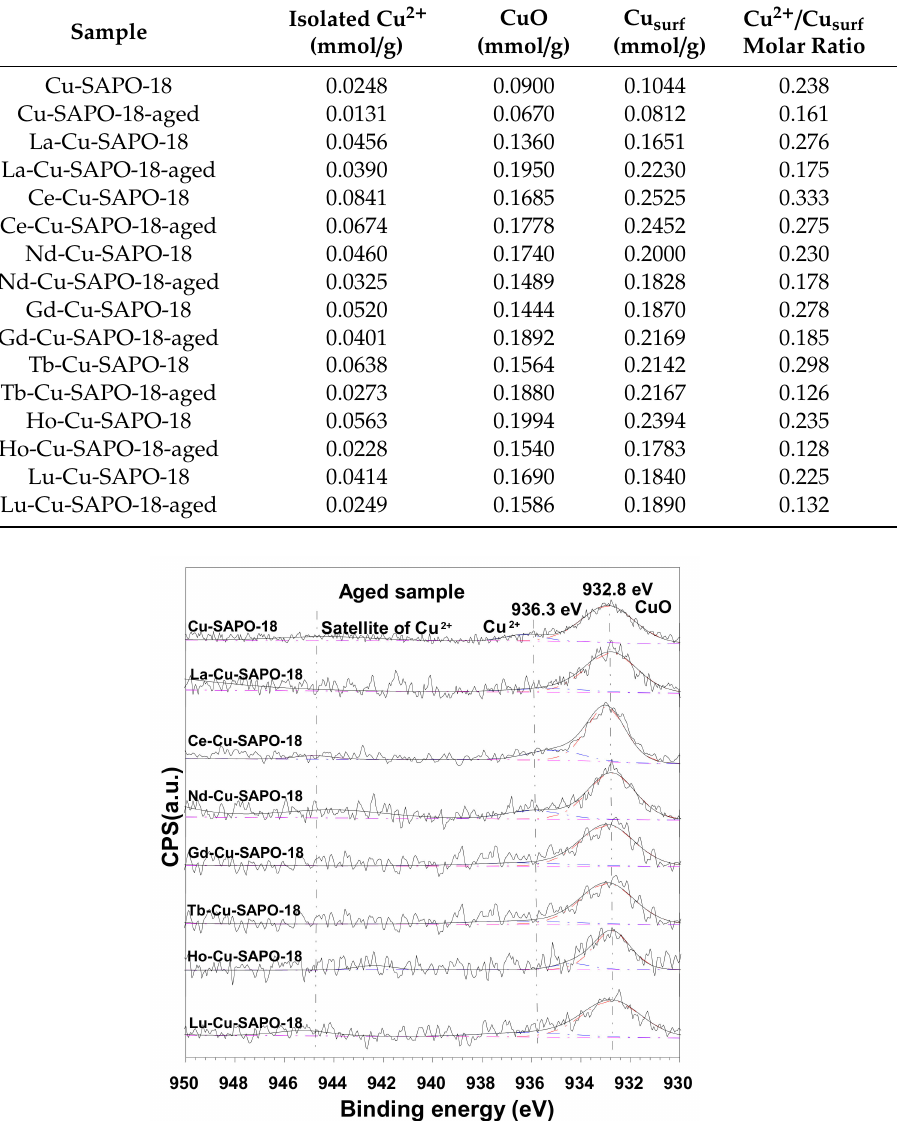
Figure 7. Cu 2p 3 / 2 XPS spectra of the hydrothermally aged Cu-SAPO-18 and M-Cu-SAPO-18